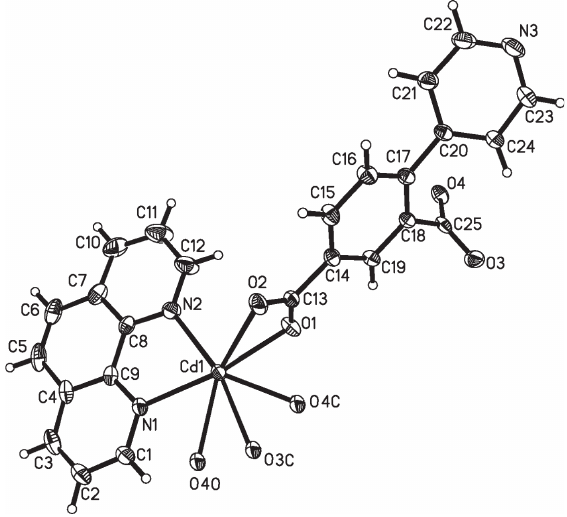
Table 1: Data collection and